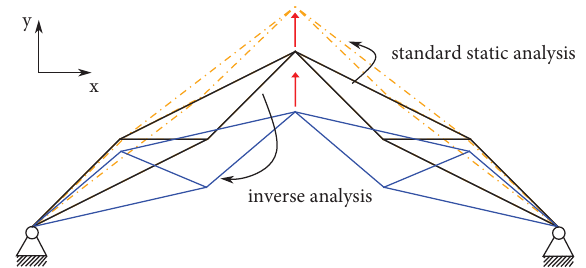
Figure 1: A standard static analysis calculates the deformation of a given reference confguration, and the displacements are the un- known variables. Te inverse analysis is used to determine the unknown reference confguration for a given deformed